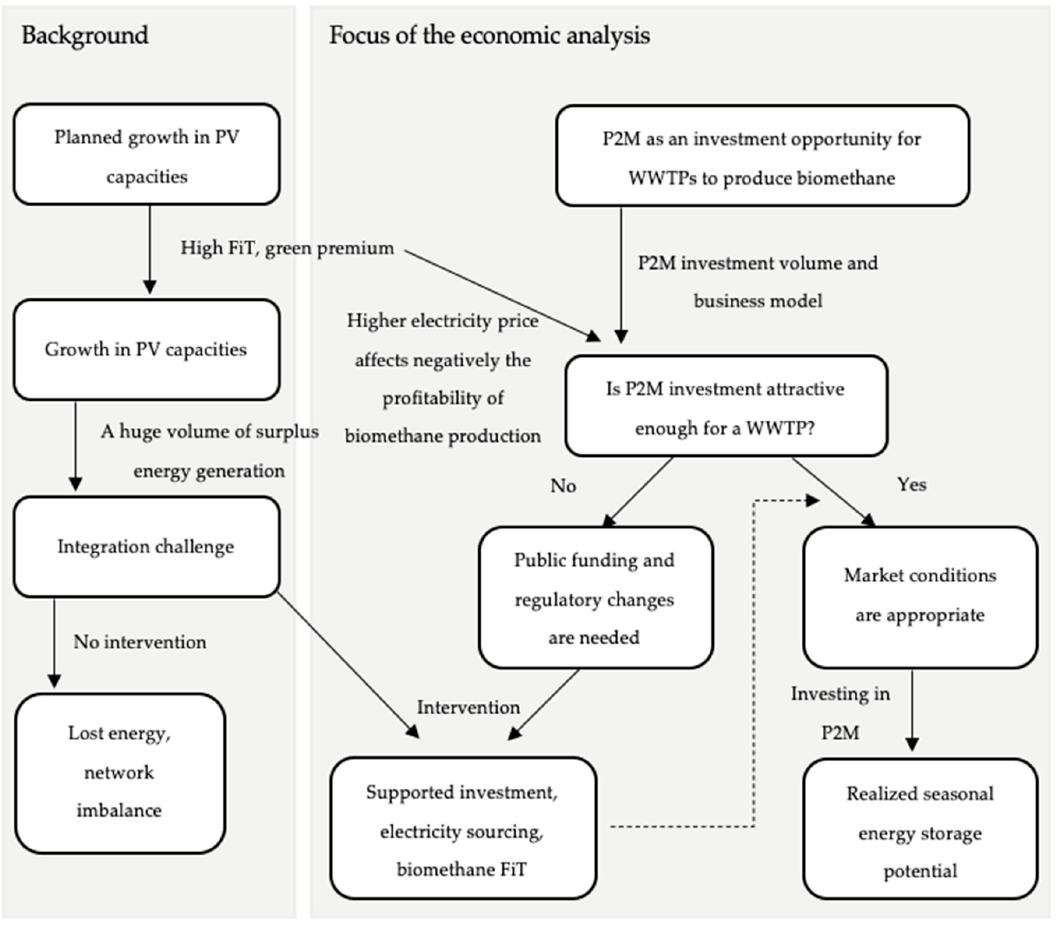
Figure 2. Model of economic analysis.